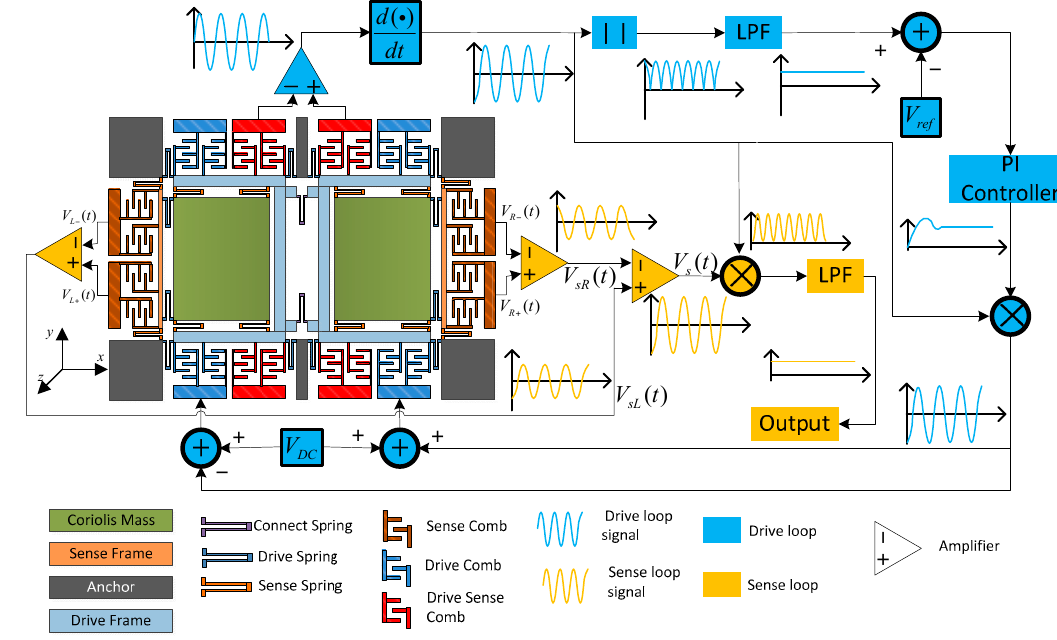
Figure 1. Schematic of the dual-mass decoupled gyroscope structure and periphery circuit.